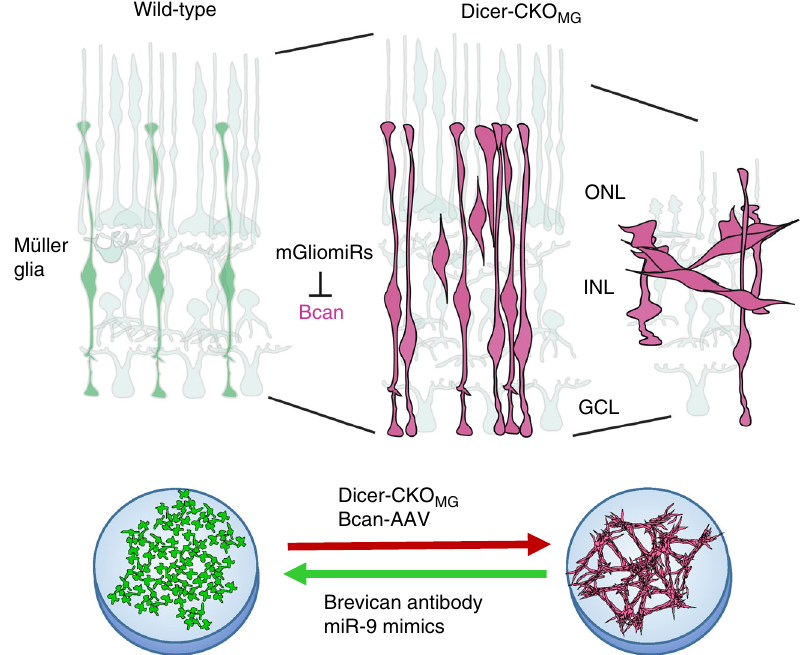
Fig. 8 Suggested mechanism for microRNA regulation of Müller glia state. miRNA depletion in retinas and cultures of MG in the Dicer-CKO MG mice leads to disorganization of the normal retinal architecture due to MG migration and aggregation, in vivo and in vitro. The gene upregulated the most in the Dicer- CKO MG and responsible for MG migration and aggregation is Bcan , which encodes for the chondroitin sulfate proteoglycan Brevican. AAV-mediated overexpression of Brevican in wild-type MG also leads to MG migration and aggregation while blocking antibodies to Brevican prevent MG aggregation in dissociated MG cultures from Dicer-CKO MG retinas. miR-9, one of the most highly expressed miRNAs in MG (mGliomiRs), targets the 3 ′ UTR of Brevican and miR-9 mimics treatment of Dicer-CKO MG MG can prevent MG aggregation and restore normal MG shape in